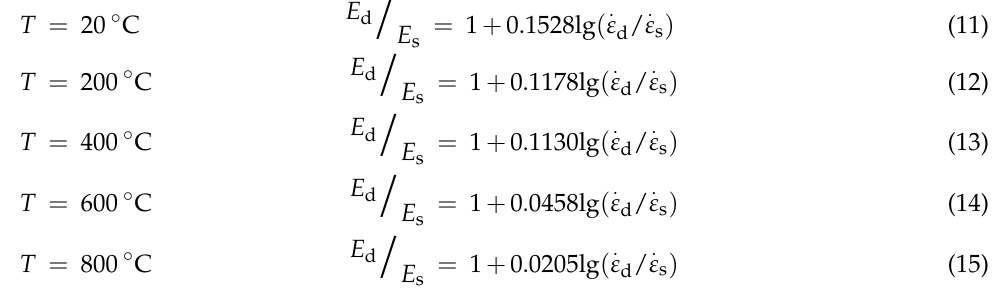
Figure 14. Change factor of elastic modulus.